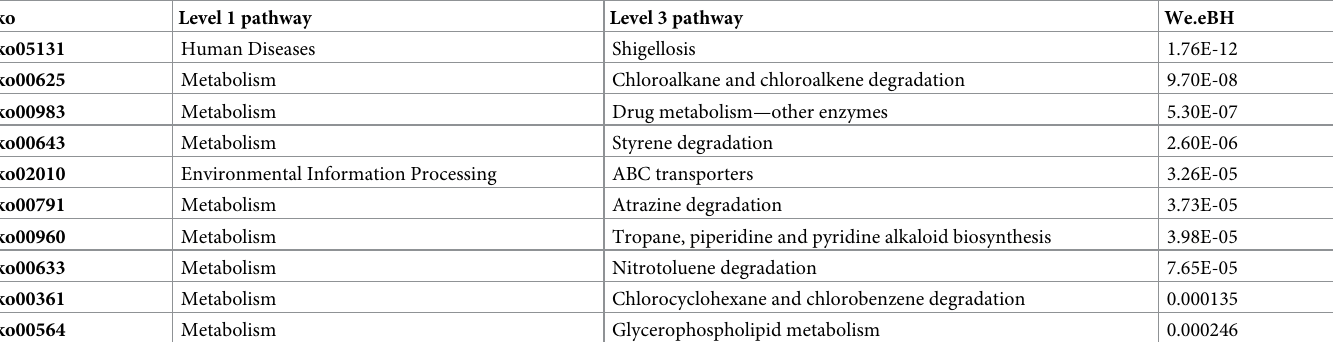
Table 2. TOP10 different